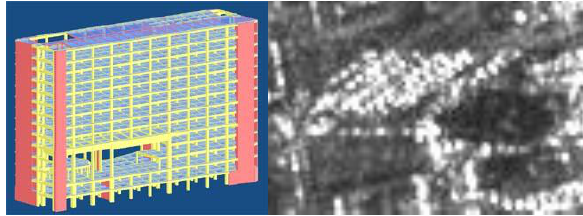
Figure 6. The 3D image and SAR image of Tongji Medical College